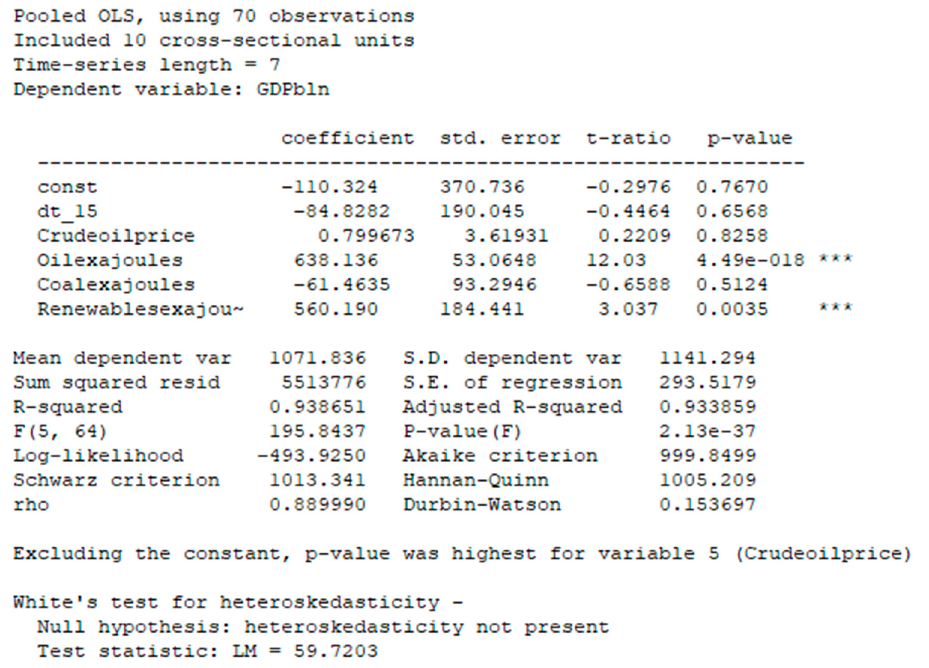
8 of 20 Figure 8. Testing on adequacy for the Fixed E ff ects model. Now we check our model for adequacy. For this purpose, we calculate 𝑦(cid:3548) (cid:3040)(cid:3028)(cid:3051) (cid:3284)(cid:3295) , 𝑦(cid:3548) (cid:3040)(cid:3036)(cid:3041) (cid:3284)(cid:3295) : based on Equations (4) and (5). Since 𝑦(cid:3548) (cid:3040)(cid:3028)(cid:3051) (cid:3284)(cid:3295) = 1785.189 , 𝑦(cid:3548) (cid:3040)(cid:3036)(cid:3041) (cid:3284)(cid:3295) = 0.545961 and our forecast GDP = 586.8418 lay in this interval, our model was adequate, which means that the fourth premise of the Gauss– Markov theorem was satis fi ed, and the coe ffi cients of the model were unbiased, con-